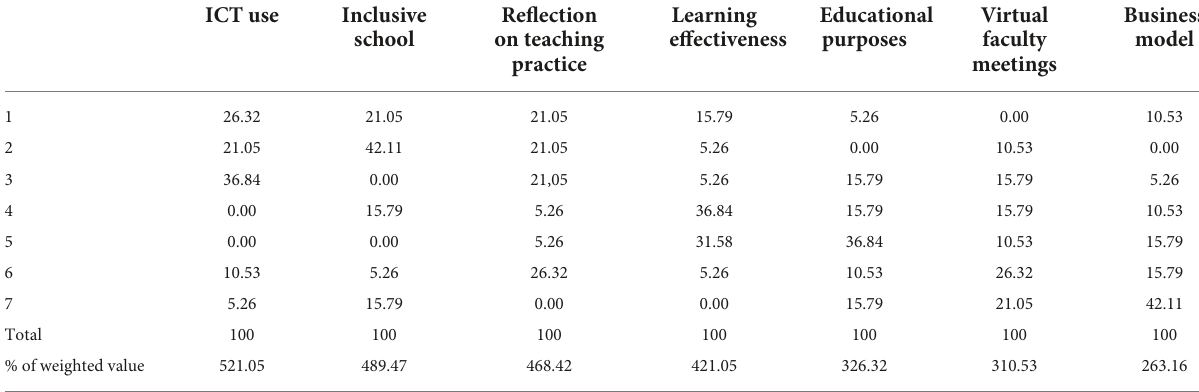
TABLE 6 Opinions on what is currently defined as educational innovation, from highest to lowest priority.